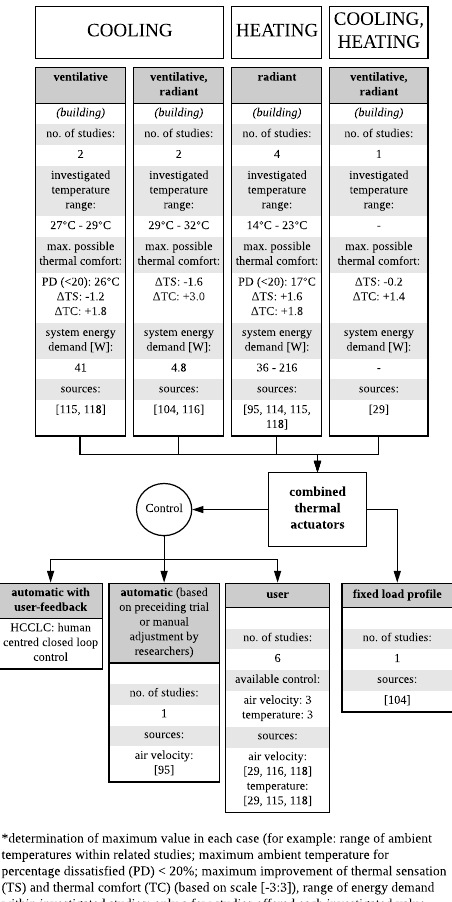
Figure A2. Summarizing chart of personalized climatization systems depending on heating and cooling method: combined thermal